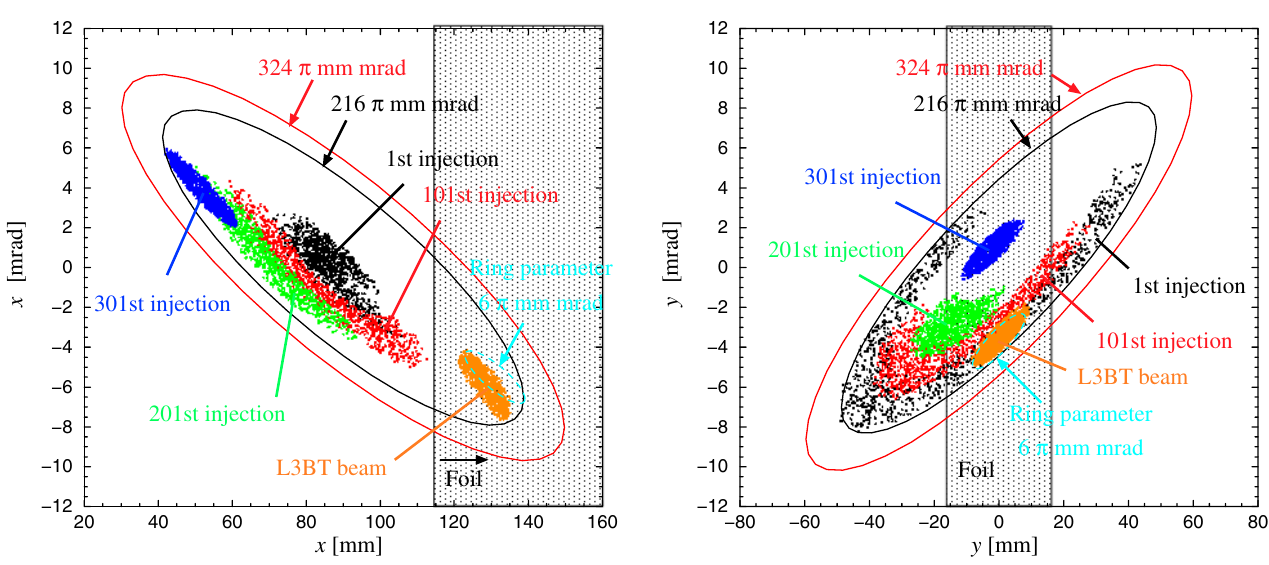
FIG. 7. (Color) Phase-space distribution of the ring optics beam of 6 (cid:1) mm mrad at the injection point ( s (cid:4) 82 : 113 m ) during 308 turns with the painting process. The 1st (black), 101st (red), 201st (green), and 301st (blue) injected bunches are traced. Ring optics of 6 (cid:1) mm mrad is shown by a broken line at the outermost position of the painting area, which corresponds to the last bunch for the horizontal plane and the first bunch for the vertical one. Beam ellipses with 216 and 324 (cid:1) mm mrad are drawn by original ring parameters without any bump orbits (bump off in Table V).